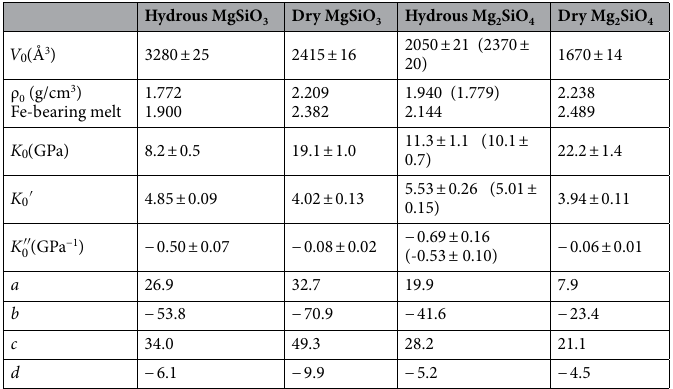
Table 1. Equation of state parameters of hydrous and dry silicate melts at 3000 K. The same parameters with higher zero-pressure density as shown apply to their Fe-bearing counterparts. The parameters for melt containing 11.4 wt% water are given in the